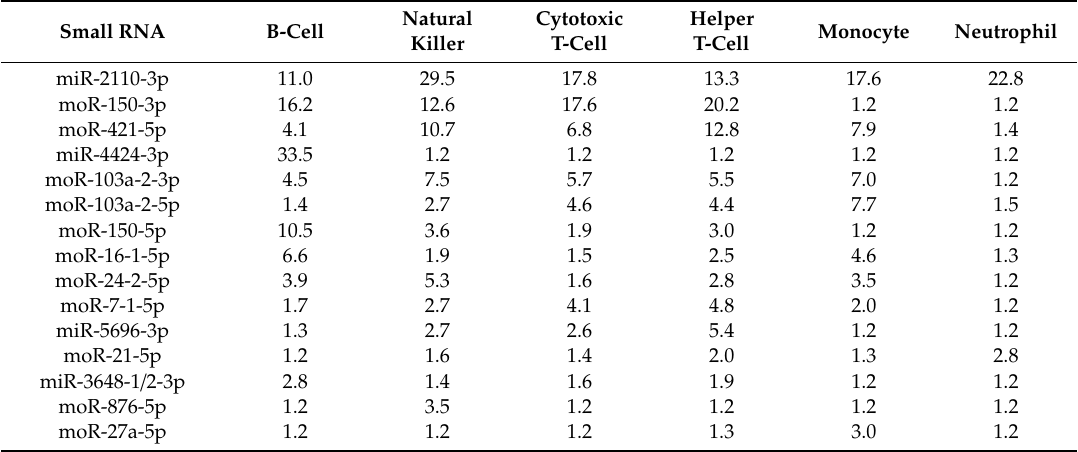
Table 2. The 15 most expressed moRNAs and new miRNAs in JUZ dataset. Normalized expression given as average counts per million mapped